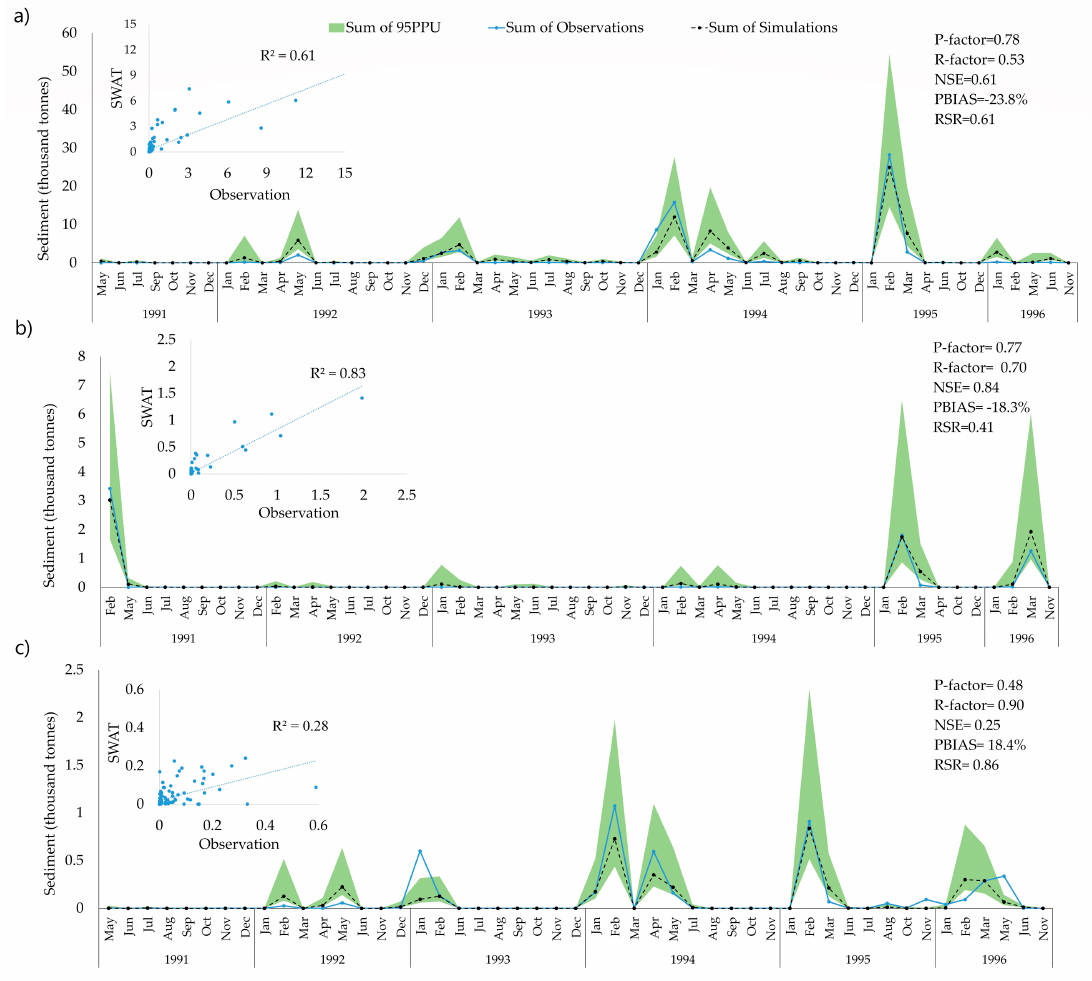
Figure 4. Results of calibration for sediment loads, showing aggregated values for each month in the calibration period of the best simulation, 95PPU, and the observation. The scatter plots show the best simulation versus the observation while the main graphs represent the monthly aggregated sediment loads: ( a ) Tung Oil station, ( b ) Glenn Allyn station, and ( c ) Fisher Creek station.